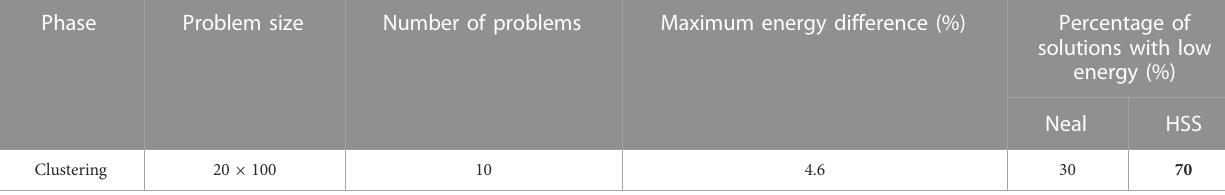
Bold is used to mean the better